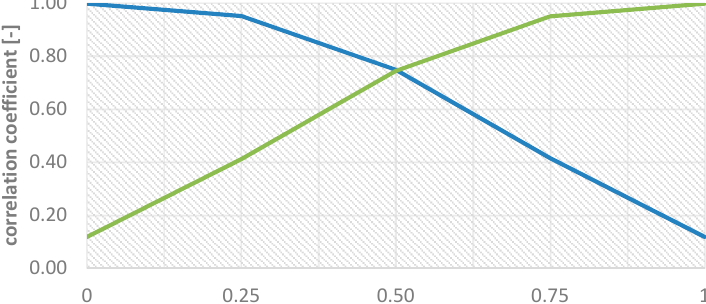
. (cid:3032) (cid:3299) . e x